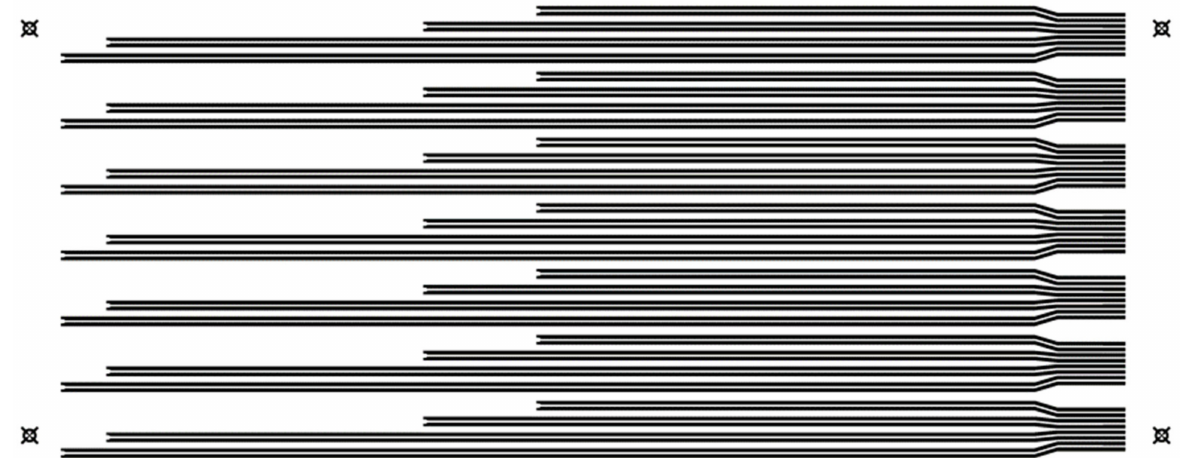
Figure 3. Pattern transferred to the printing screen. An 80 × 65 cm frame was used, so seven identical multi-sensors were included.